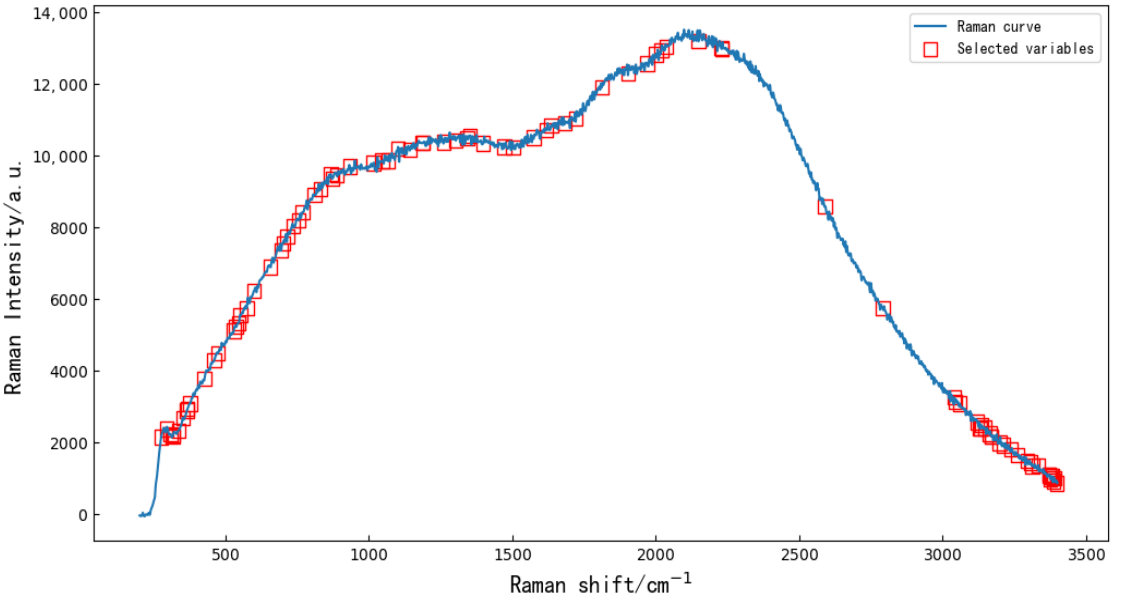
Figure 2. Random forest algorithm was used to extract 90 characteristic variables from the original Ranman spectra.